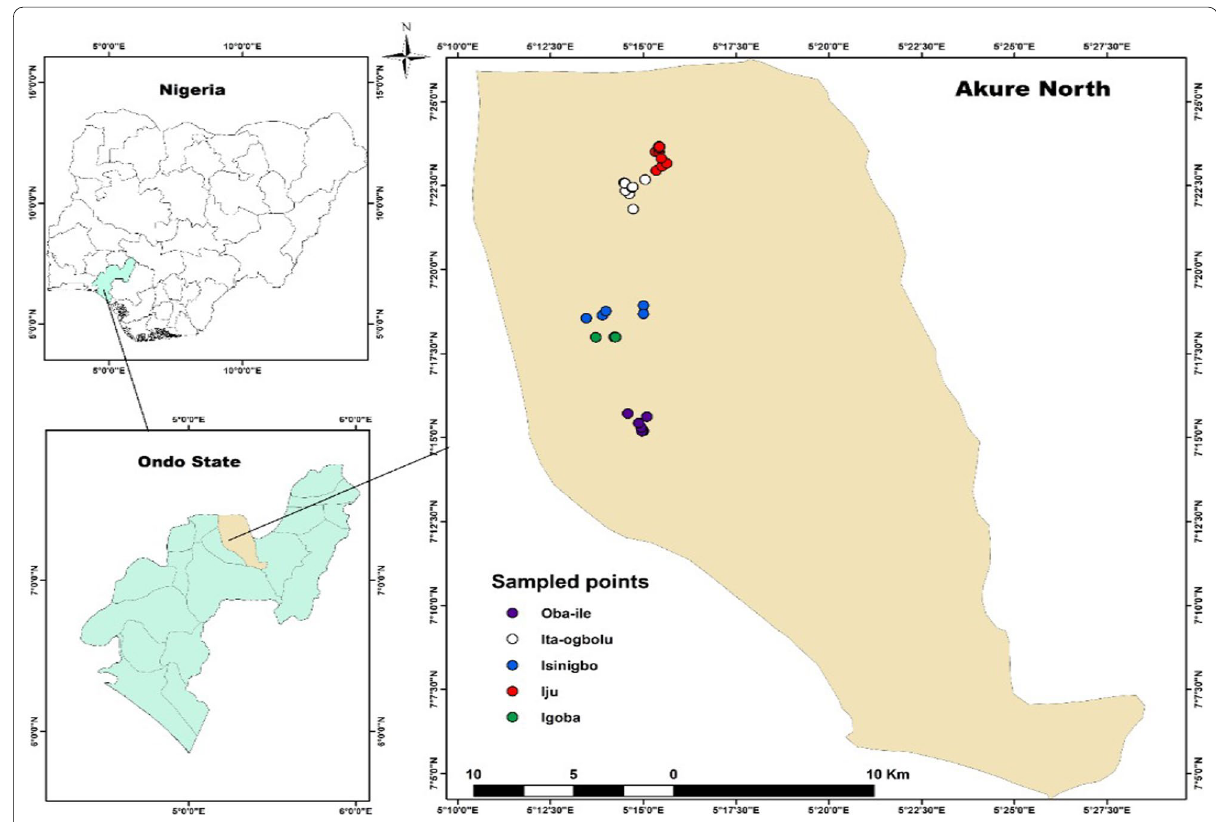
Fig. 1 Map of Akure North Local Government area showing the sample collection